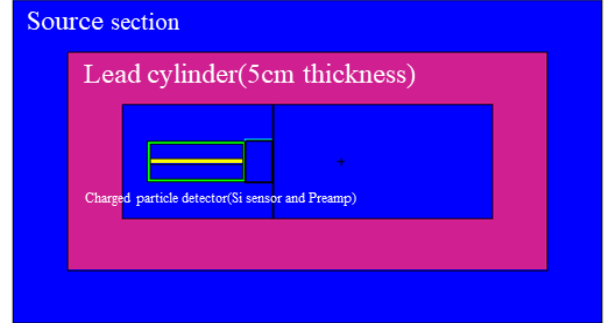
Fig. 2. MCNP geometry to calculate the absorbed dose rates on silicon sensor and preamplifier